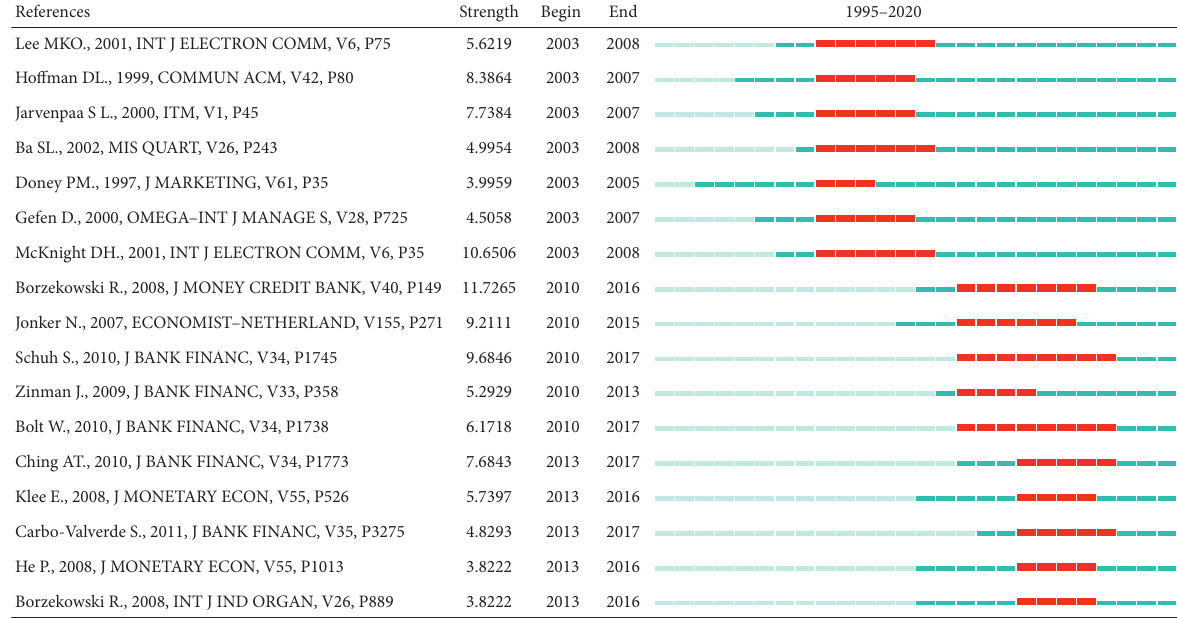
Figure 7: The publications with citation burst year beginning in 2003, 2010, or 2013. Table 6: Most recently formed clusters of keywords. Cluster #